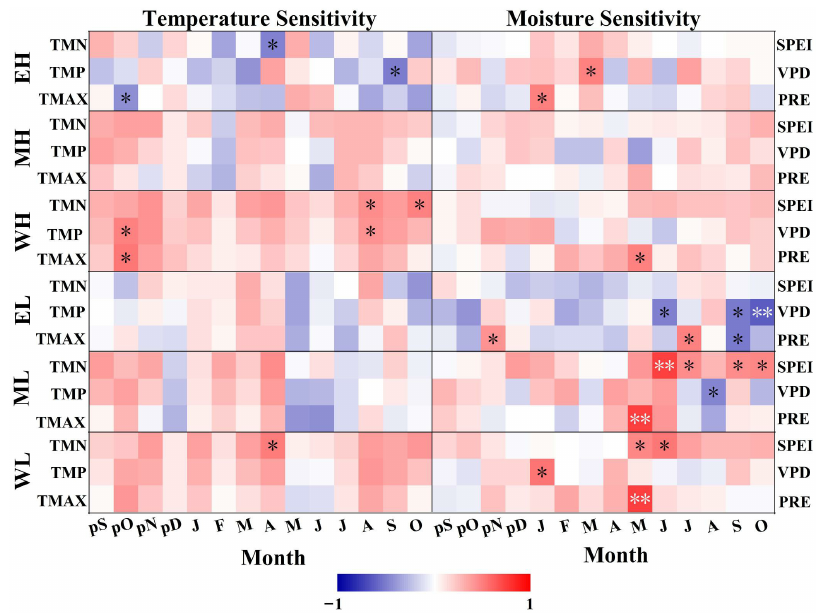
Figure 8. Correlations between TRW and climate factors from September of the previous year to October of the current year in the Qilian Mountain regions from 2000 to 2020. ** p < 0.01; * p < 0.05. The sensitivity of TRW to climate was weaker for short time series; in order to find the main control factors affecting TRW, we further analyzed the sensitivity of TRW to climate for a long time series from 1960 to 2020 (Figure 9).